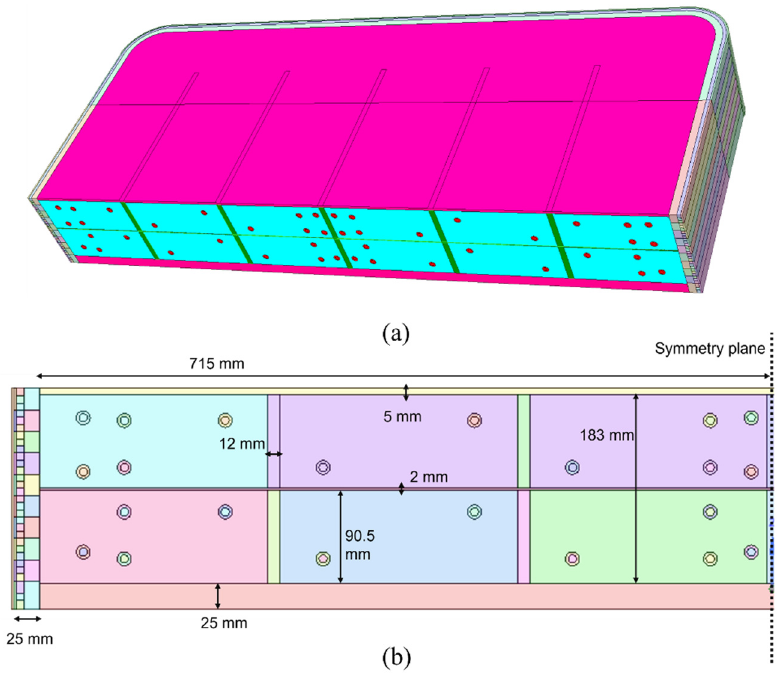
Figure 1. ( a ) Isometric view of the analyzed bottom cell and ( b ) toroidal–poloidal rear-view cut on the radial–poloidal symmetry plane.